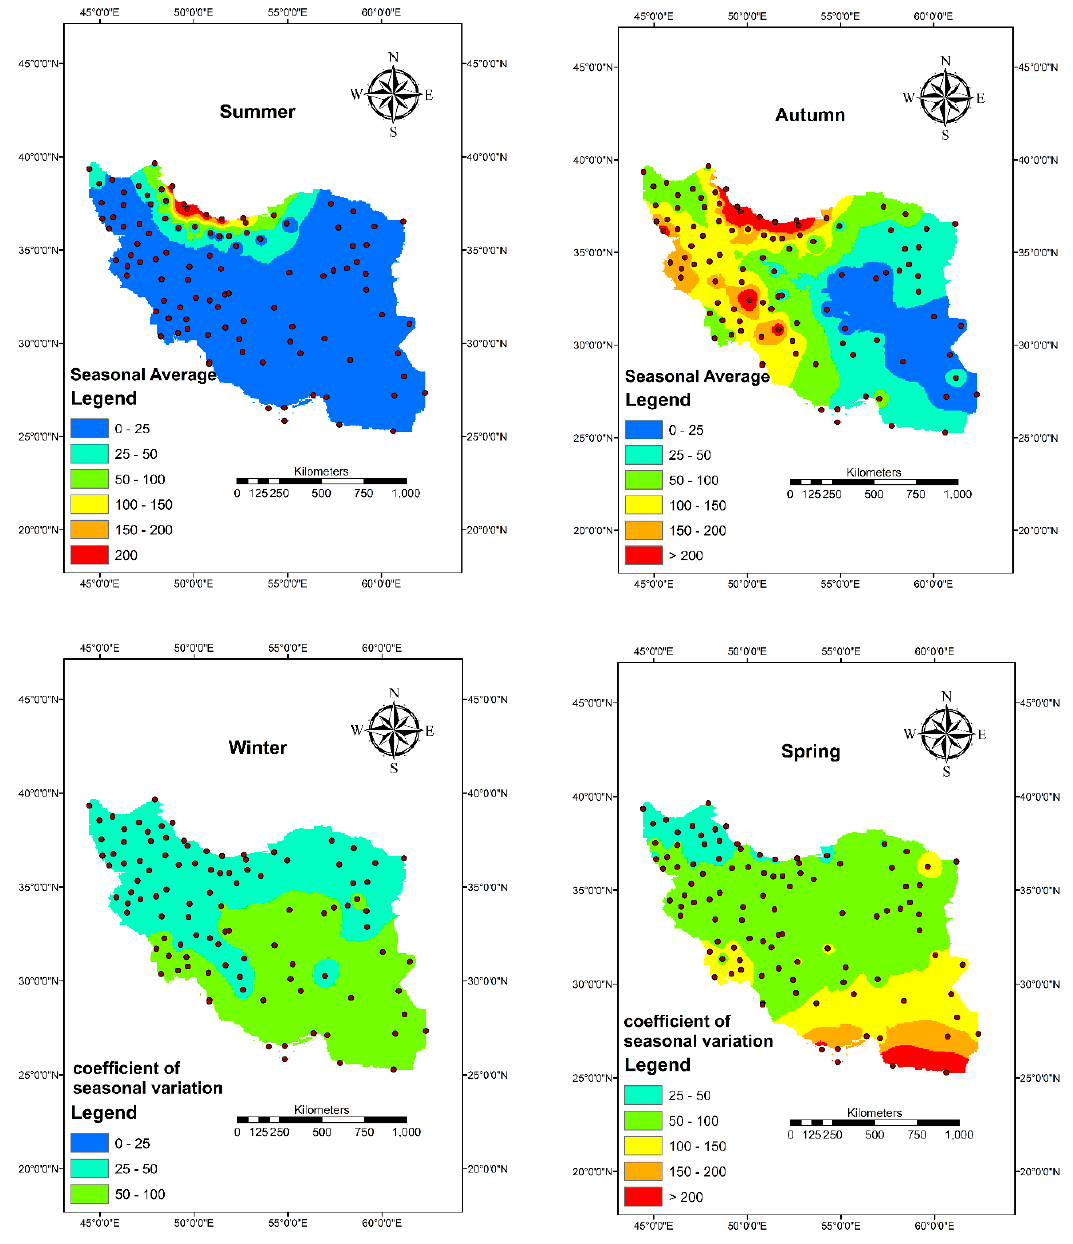
Figure 2. The long-term average of the precipitation and coe ffi cient of variation (in percent) for Winter, Spring, Summer, and